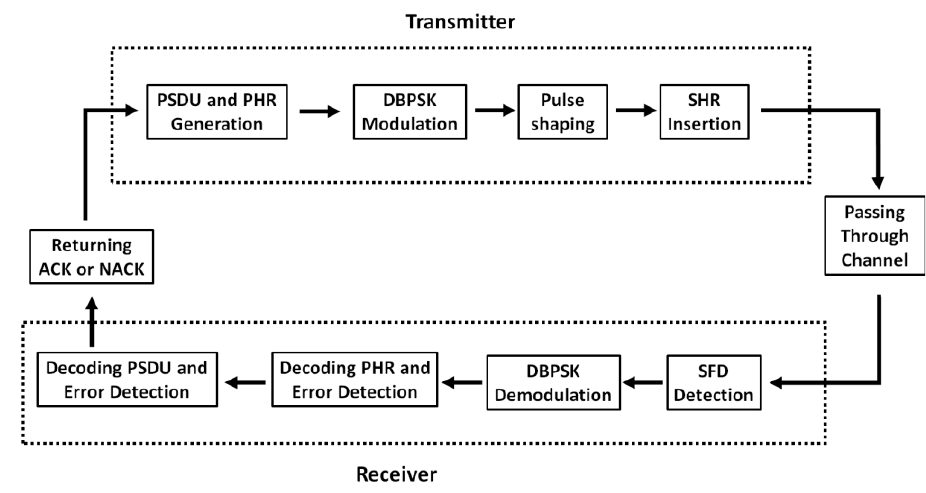
Figure 5. Block diagram representing the system model.